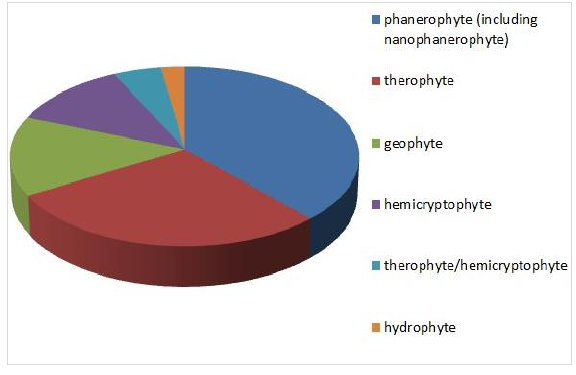
Fig. 1. Distribution of invasive species by their life form